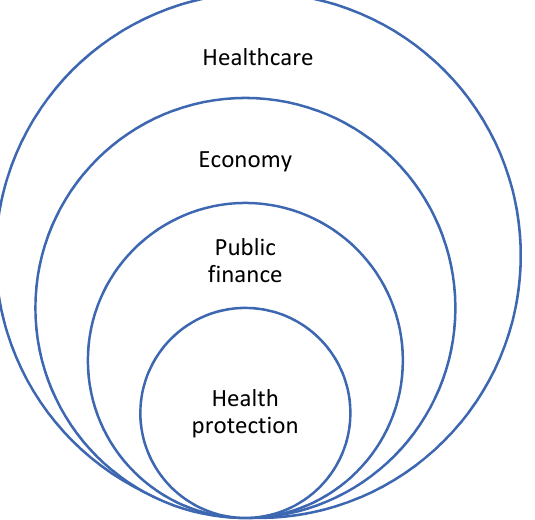
Figure 1. Spheres of impact on healthcare operation. Source: authors’ own material.